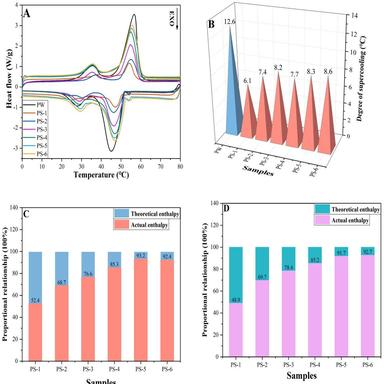
DSC curves (A), degree of supercooling (B), comparison of theoretical and actual enthalpies in (C) melting process and (D) solidifying process of the samples.